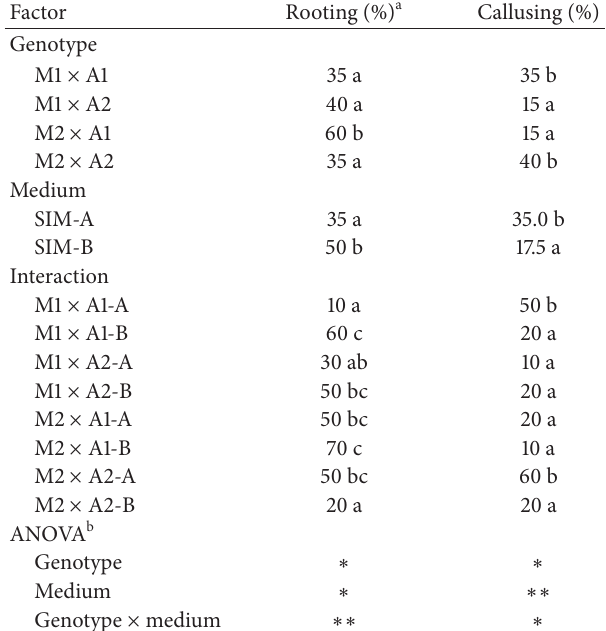
Table 5: Influence of the SIM on adventitious shoot rooting. Frequency of plants with roots and basal callus formation at 30 days of culture in